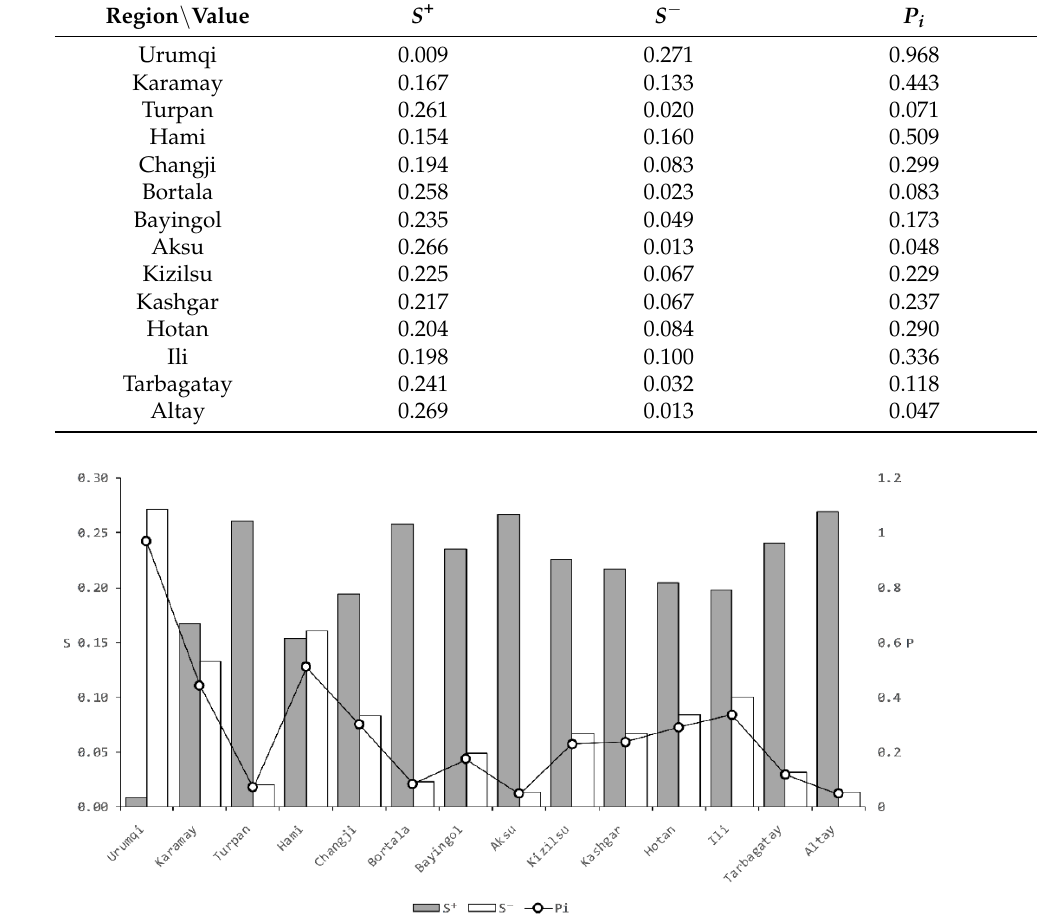
Table 8. Basic medical service equalization scores in various regions.